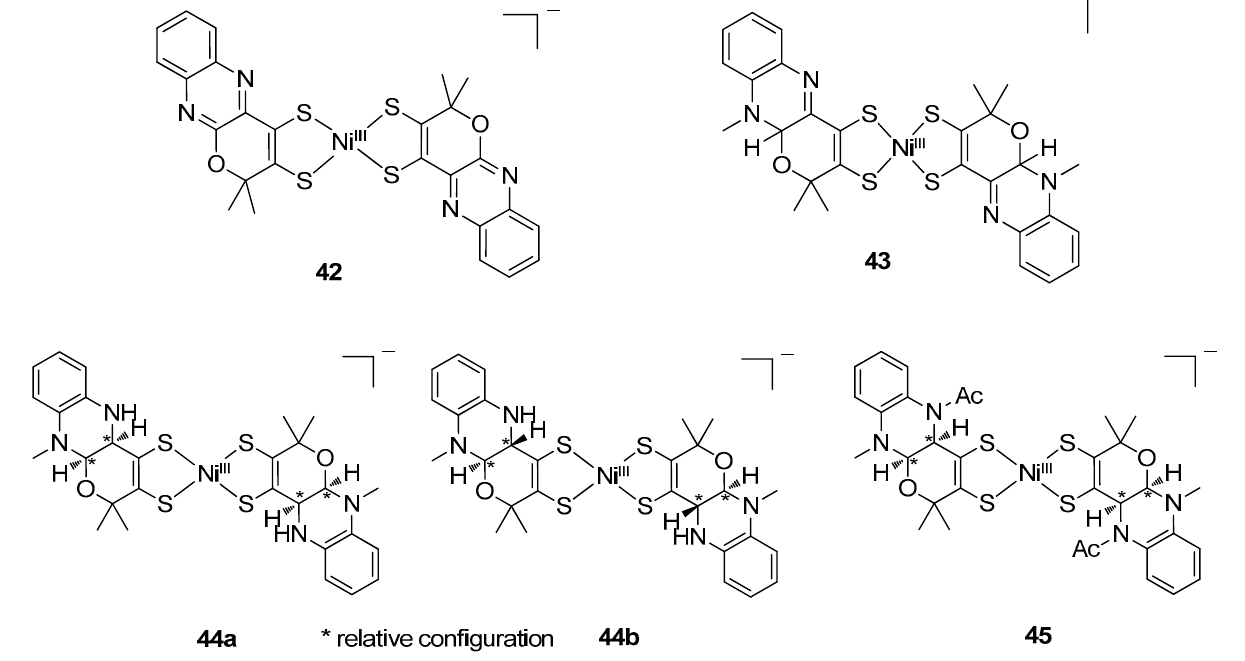
Figure 10. Structures of complexes [Ni III (qpdt) 2 ] ‐ ( 42 ), [Ni III (H ‐ qpdt) 2 ] ‐ ( 43 ), and [Ni III (2H ‐ qpdt) 2 ] ‐